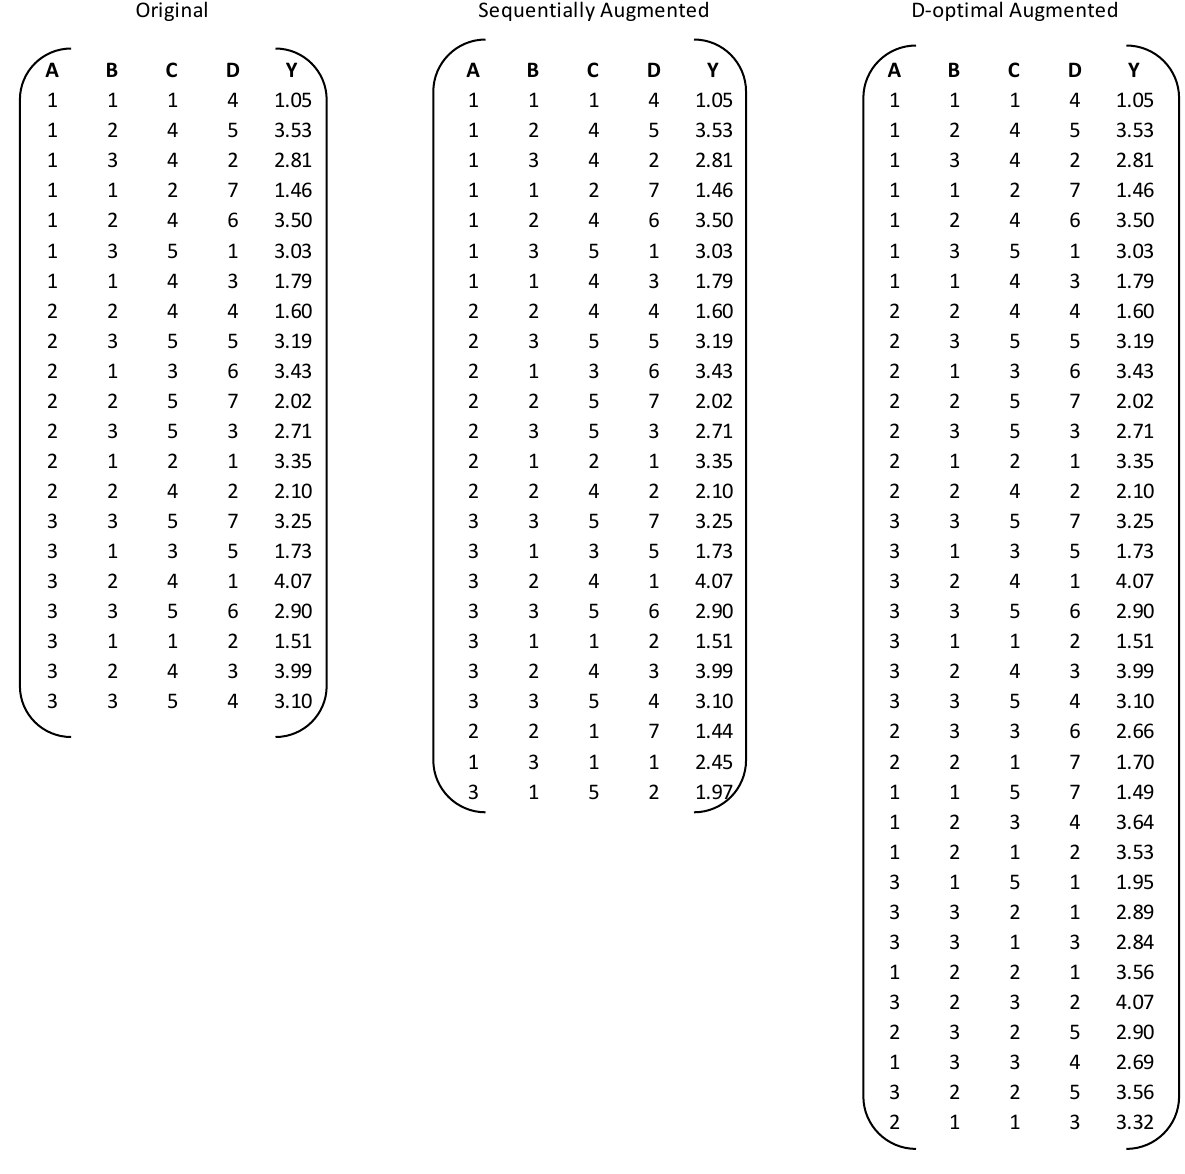
Figure 19. Simulated data for original, sequentially augmented, and D-optimal augmented designs.